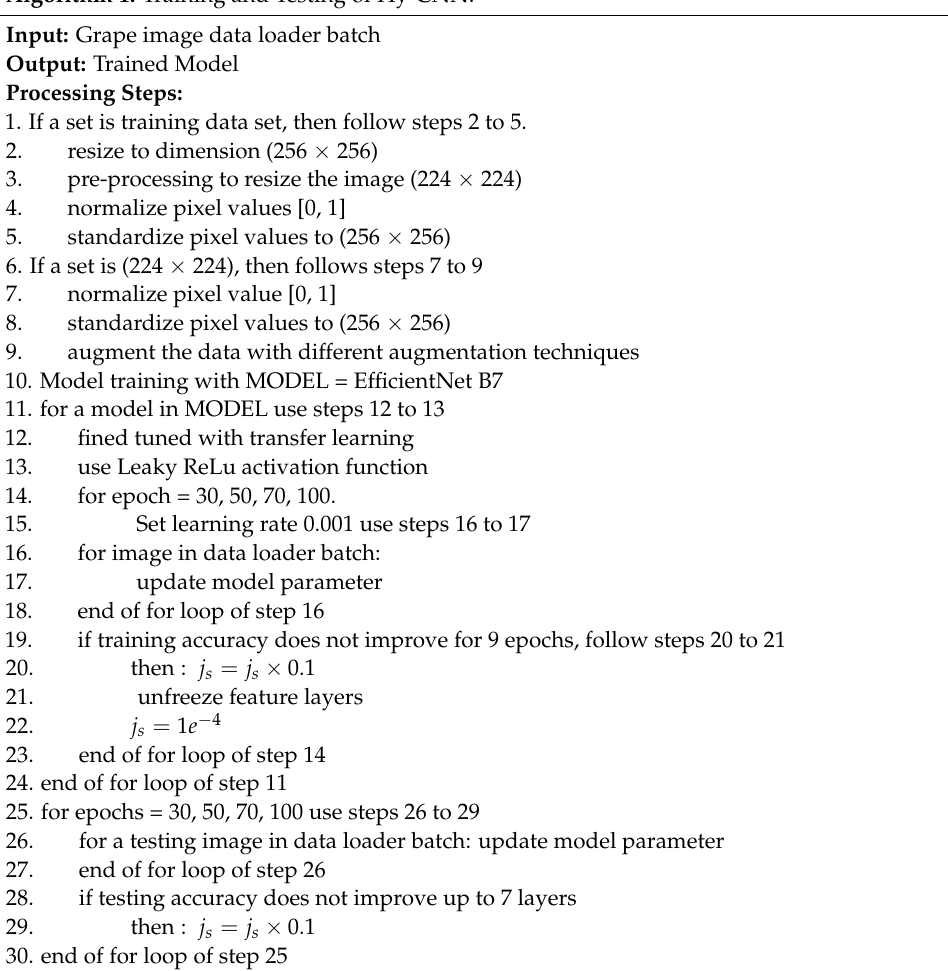
Algorithm 1: Training and Testing of